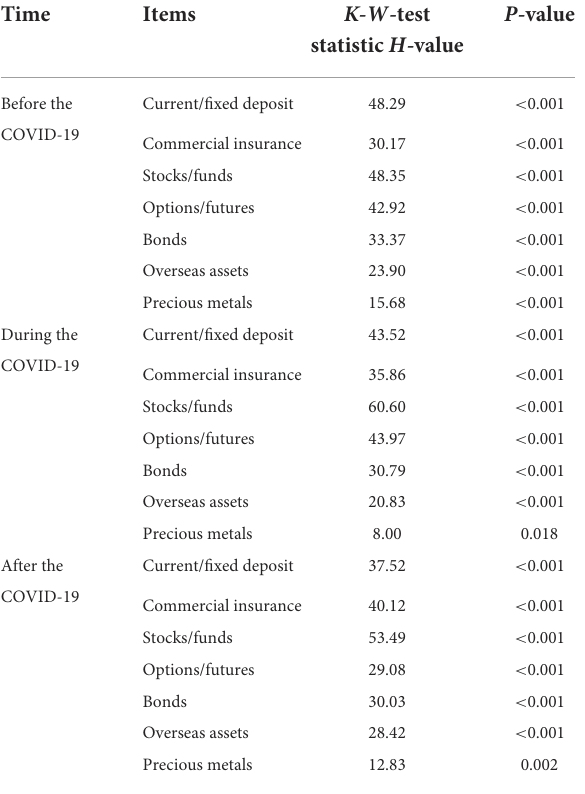
TABLE 9 A test of the variability of different risk attitudes on household financial asset allocation before the epidemic.